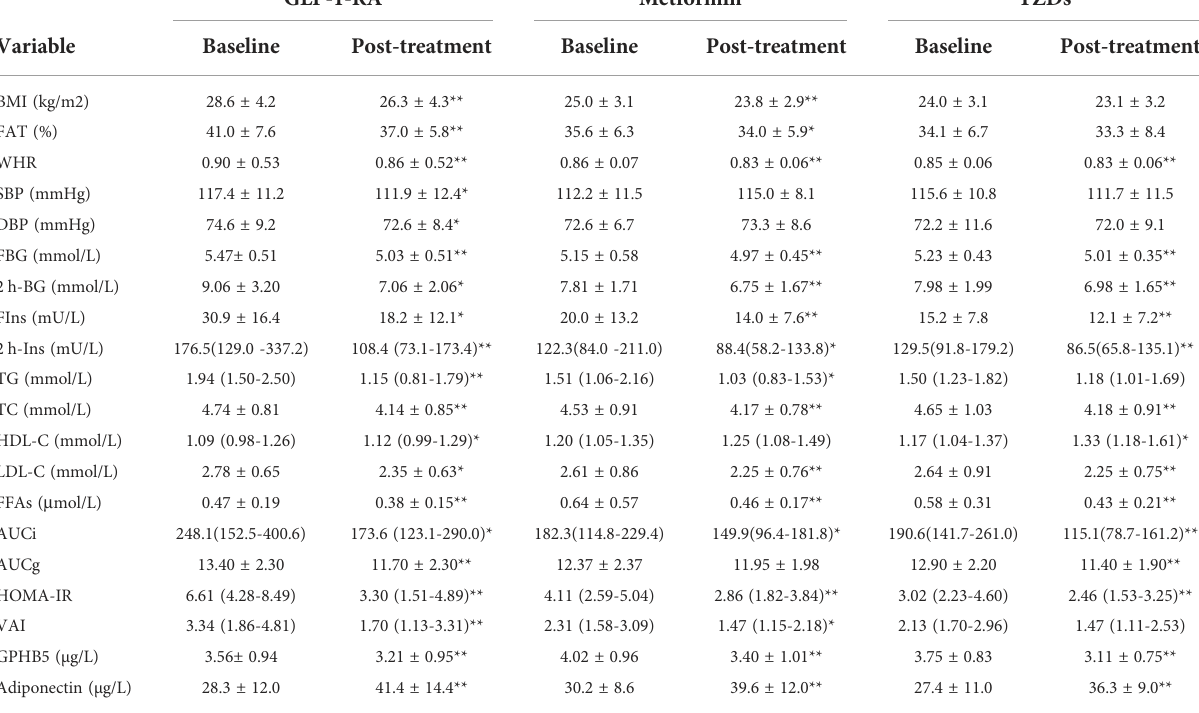
TABLE 5 Main clinical and metabolic features pre-and post-treatment with the anti-diabetes drug in PCOS